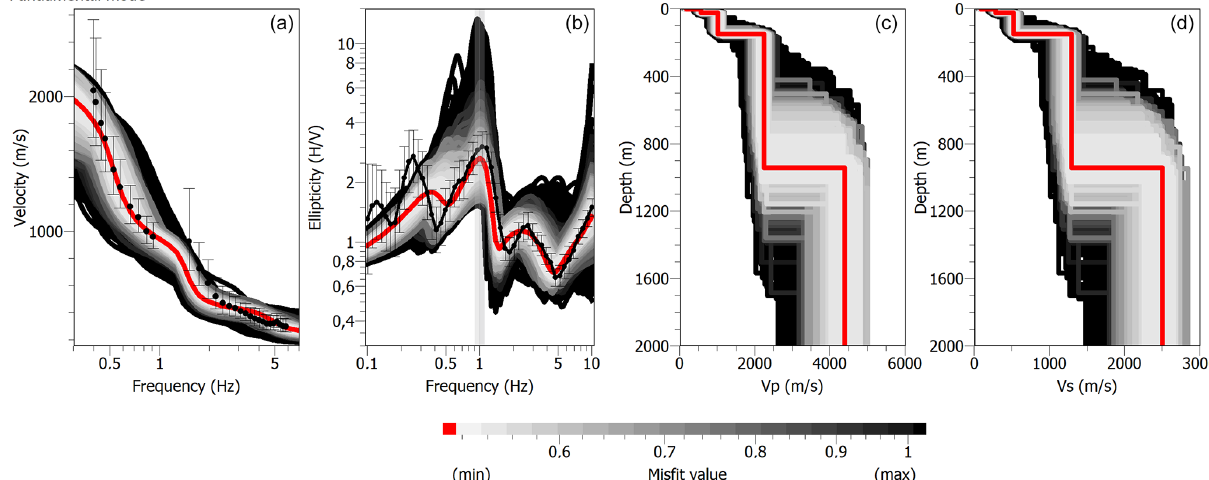
Figure 8. Results of the joint inversion of averaged dispersion curve and H/V data. (a) Observed phase velocities (black dots) and relative error bars, phase velocities for the minimum cost model (red line), and phase velocities for the space of stable generated models (gray band). (b) Mean H/V (black dots) and relative error bars, ellipticity function for the fundamental mode of Rayleigh waves for the minimum cost model (red line), and ellipticity functions for the space of stable generated models (grey band). The grey vertical band identify the mean frequency peak f 0 . (c) and (d) minimum misfit P and S wave velocity models (red line) and space of stable generated models (grey band).